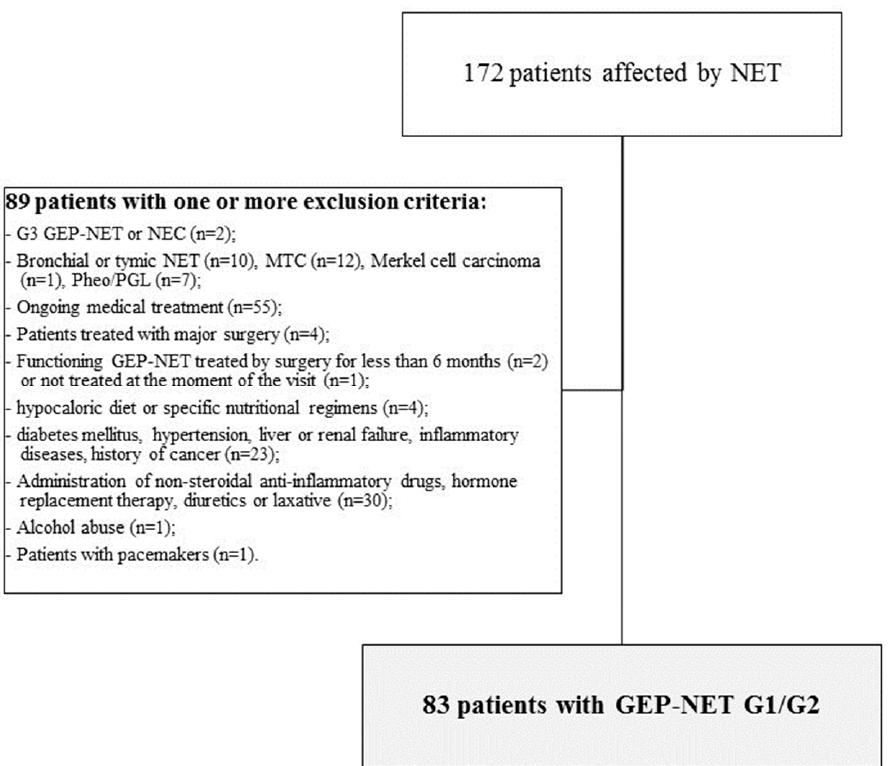
Figure 1. Flow chart of the studied subjects. A total of 83 patients affected by well differentiated GEP-NET G1/G2 selected from 172 patients with NET attending the ENETS Centers of Excellence Multidisciplinary Group for Neuroendocrine Tumors, University “Federico II”, Naples. Abbreviation: NET, Neuroendocrine Tumor; GEP-NET, Gastroenteropancreatic NET; MTC, medullary thyroid cancer; Pheo/PPG, Pheochromocytoma/paraganglioma; ENETS, European Neuroendocrine Tumor